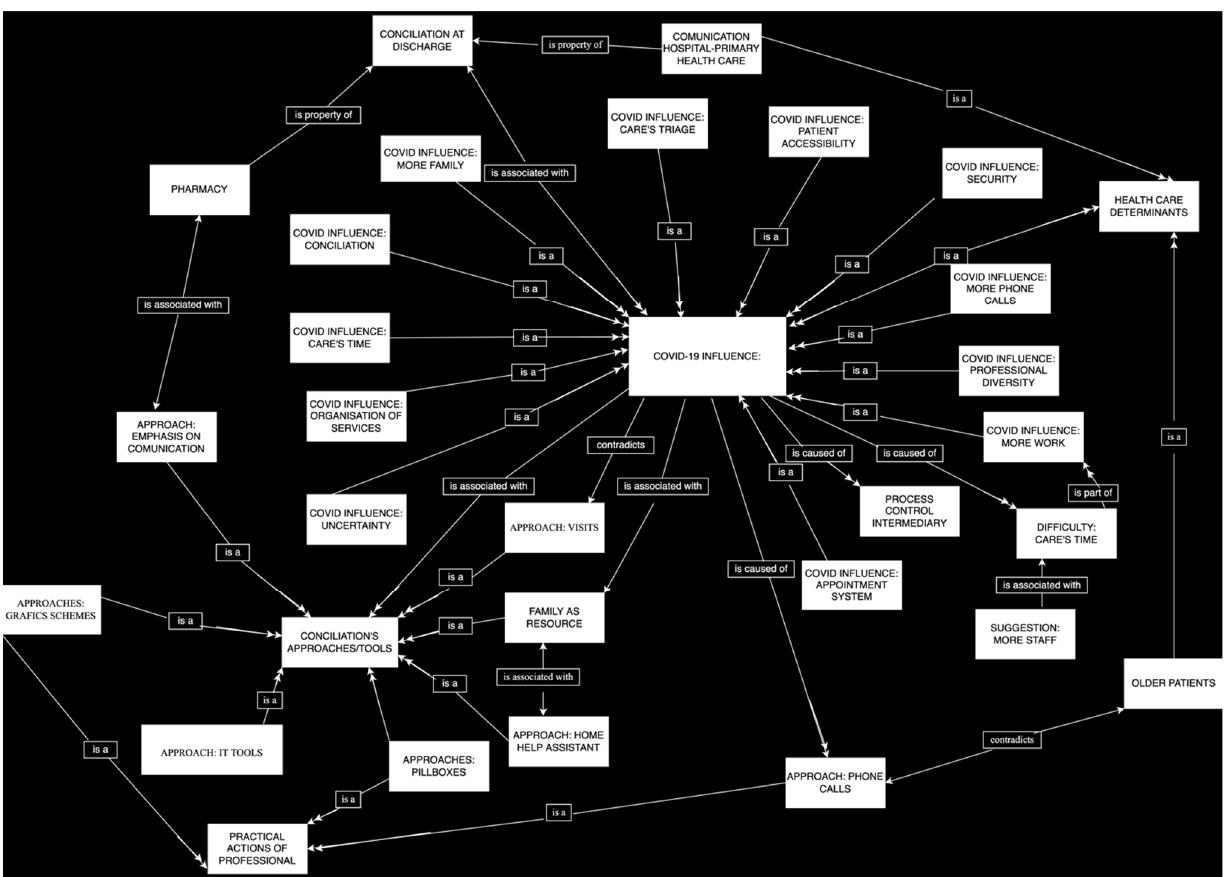
Figure 1. Codes relating to COVID-19 influence on medication reconciliation.